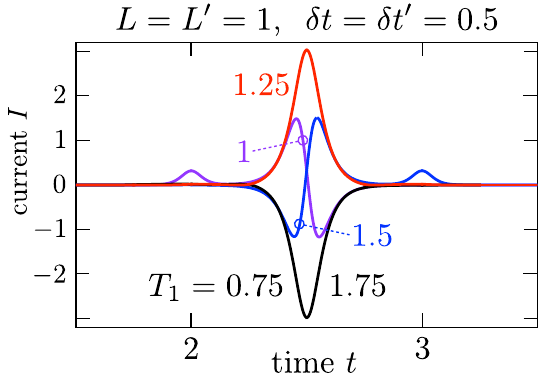
Figure 8: Same as Fig. 6, but now for the geometry of Fig. 7. The curves are calculated ( t ) given by Eq. (3) and β ( t ) given by Eq. (39). We took from Eq. (42), with α A B = 5 and incremented φ W /ξ , φ by 2 π with a constant rate d φ/ dt = 2 π . The A B 0 = 0.75 and 1.75 are curves are for five different values of T (the curves for T 1 1 indistinguishable). The ± e / 2 current pulse from the fusion of vortices σ and σ 1 2 changes sign when T is in the interval ( L , L + δ t ) = ( 1,1.5 ) in which σ is braided 1 1 with σ 3